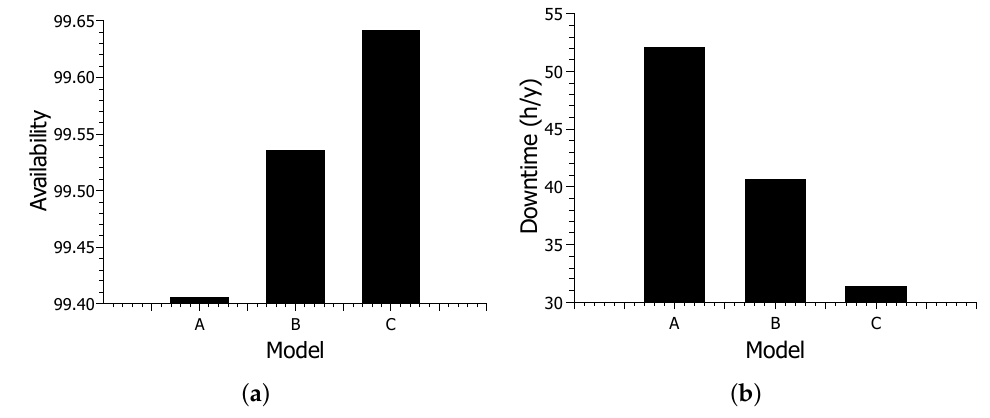
Figure 10. Results for availability models: ( a ) availability; ( b )